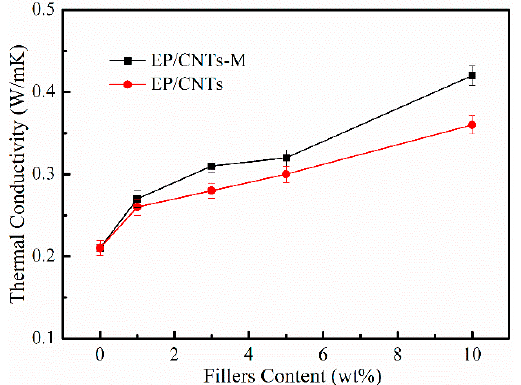
Figure 10. Thermal conductivity of EP and EP/CNTs-M with different content of CNTs-M.